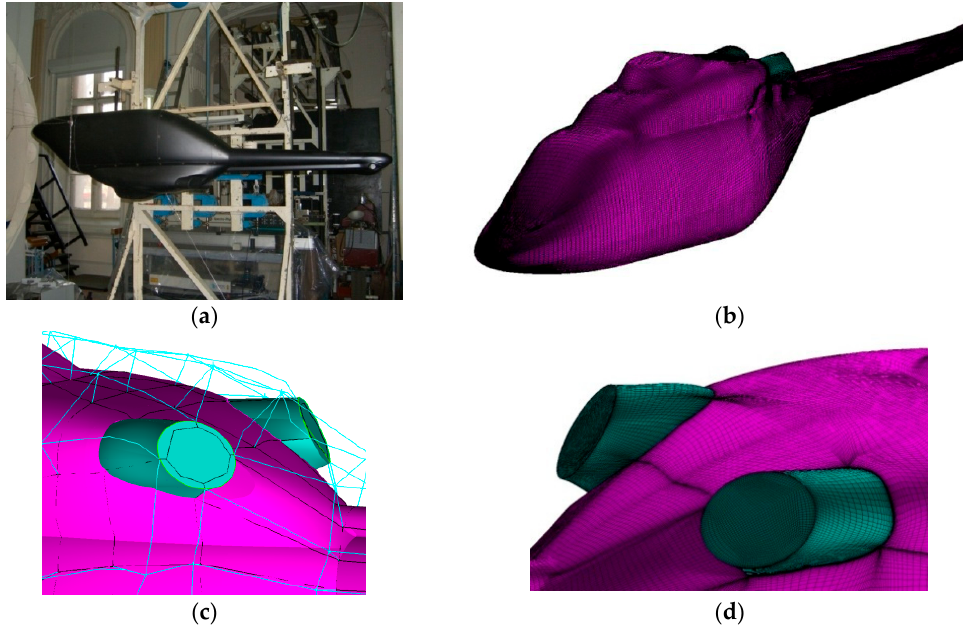
Figure 1. ( a ) Ansat-P fuselage model in the T-1K wind tunnel of KNRTU-KAI, ( b ) surface grid for fuselage, ( c ) multi-block topology, and ( d ) surface mesh near exhausts.